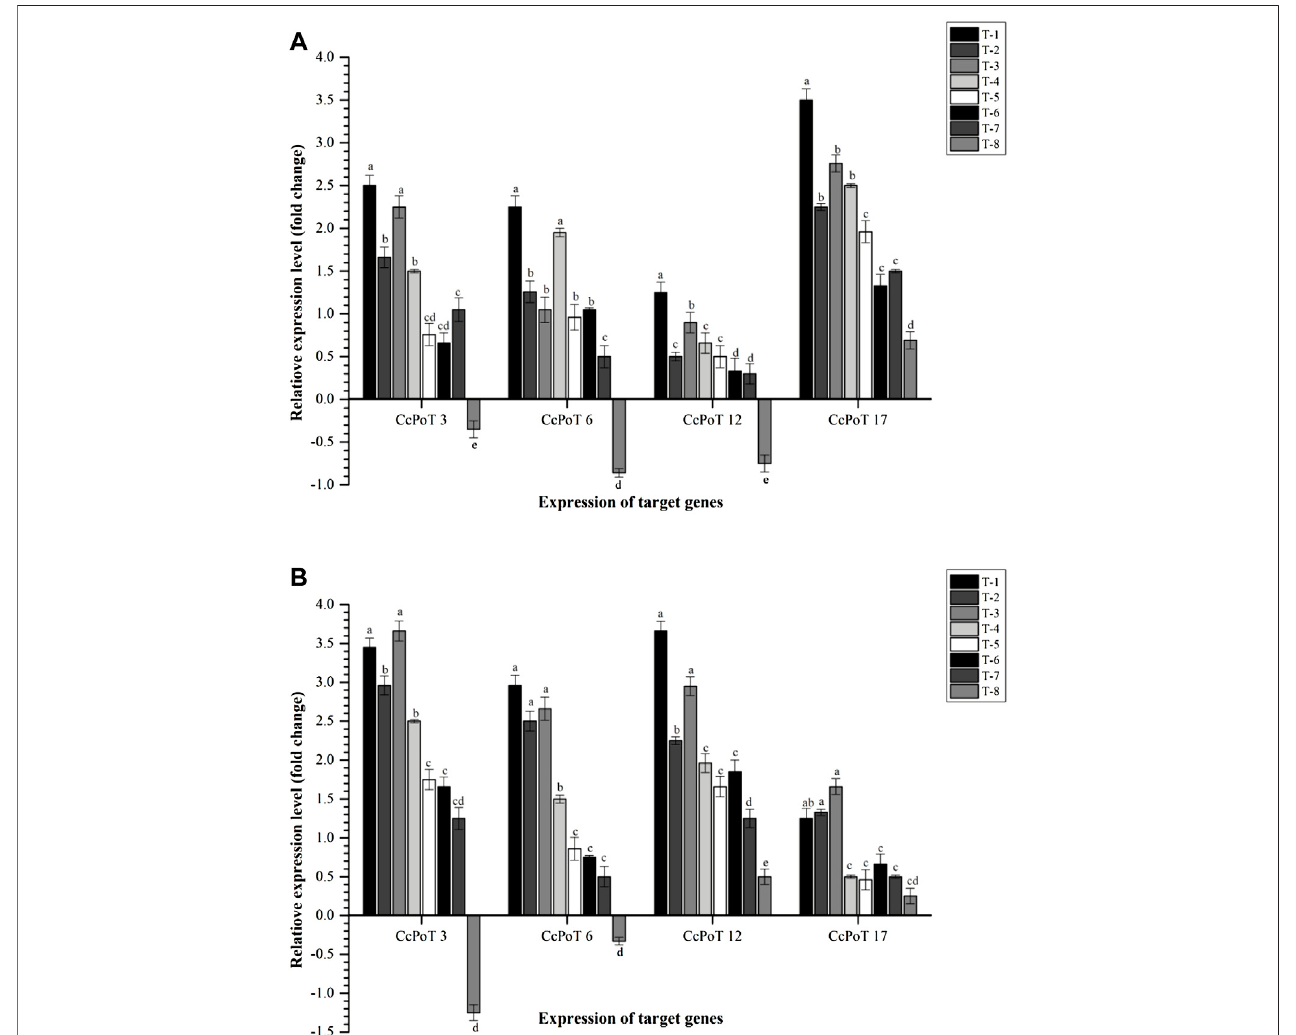
FIGURE 9 | Effects of seed inoculation of SOB on expression of potassium transporters in the pigeonpea leaves at (A) 30 and (B) 60 days of sowing. Treatments were as follows: T1 — Stenotrophomonas maltophilia DRC-18-7A, T2 — S. maltophilia DRC-18-10, T3 — S. pavanii DRC-18-7B, T4 — S. pavanii DRC-18-11, T5 — R. pusense DRC-18-25, T6 — R. pusense DSC-18-5, T7 — R. pusense DJC-18-21, and T8 — Untreated control (No inoculation). Data are mean ( n = 5) and vertical bar representsthestandarddeviation.Datawithdifferentlettersshowsigni fi cantdifferenceincolumndatainrandomizedblockdesigntestat p < 0.05underDuncan ’ s multiple-range